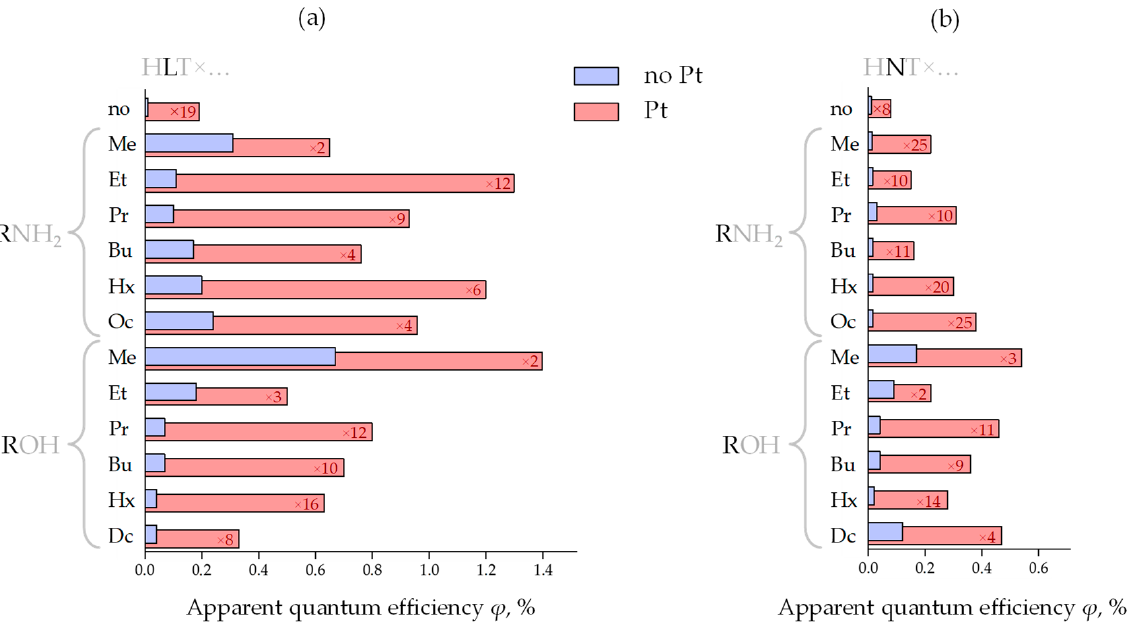
Figure 4. Apparent quantum efficiency of photocatalytic hydrogen evolution over the initial proto- nated forms and inorganic–organic derivatives of HLT ( a ) and HNT ( b ) titanates in a bare state and with a Pt cocatalyst as well as platinization increase factors k Pt